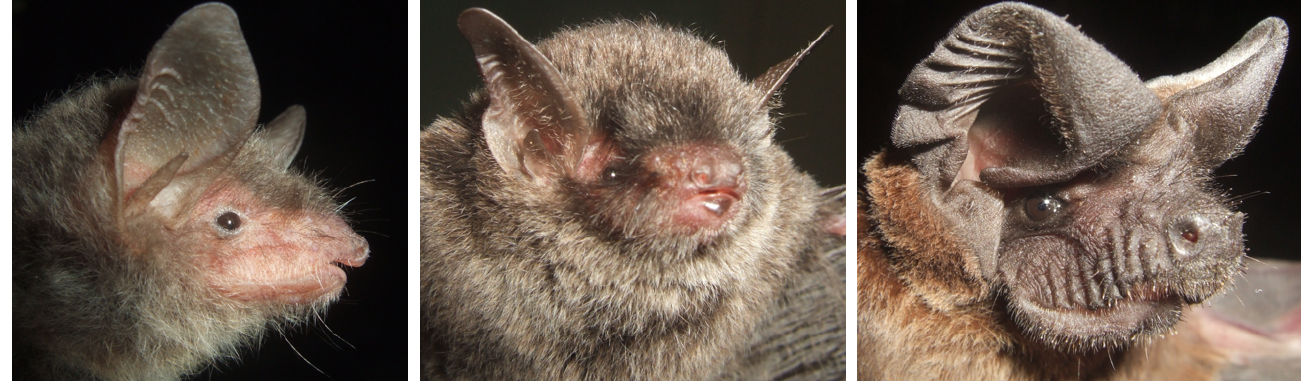
Figure 4. Frontolateral view of FM bat species: M. pilosus ( left ), M. cf. muricola ( center ) and M. plicatus ( right ). Photos: Vu Dinh